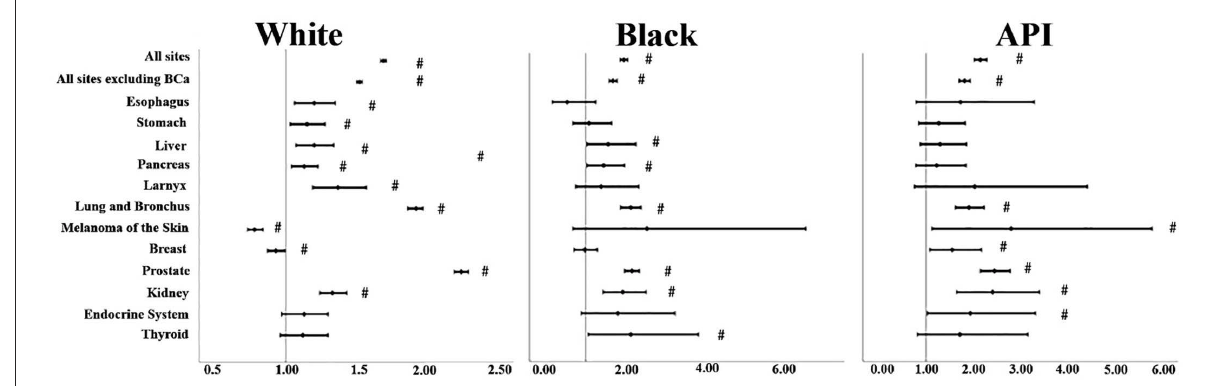
FIGURE1 SIRs for second primaries at various anatomical sites based on the different races. “#” signified an SIR of p < 0.05.